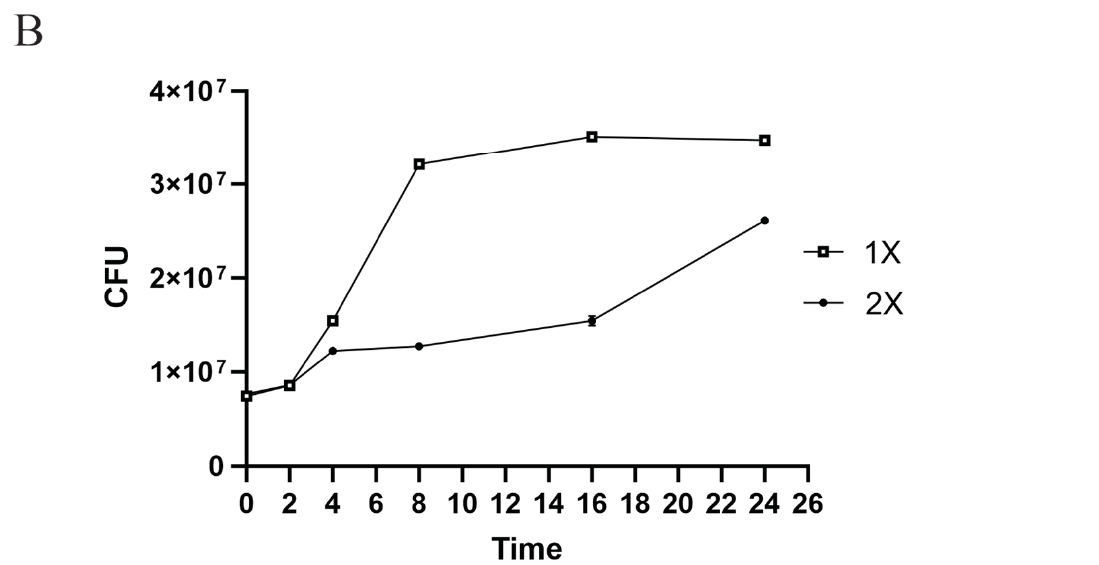
Figure 1. Analysis of the viability of the 1390S strain after continuous stimulation with high concentrations of ampicillin at 16, 32, 64, and 128 µ g/mL. ( A ) Growth curves in presence of selective pressure ( p < 0.0001). ( B ) Recovery of resistant strains from the high-stimulus conditions and growth at 1 × and 2 × MIC (2 and 4 µ g/mL) ( p < 0.01).